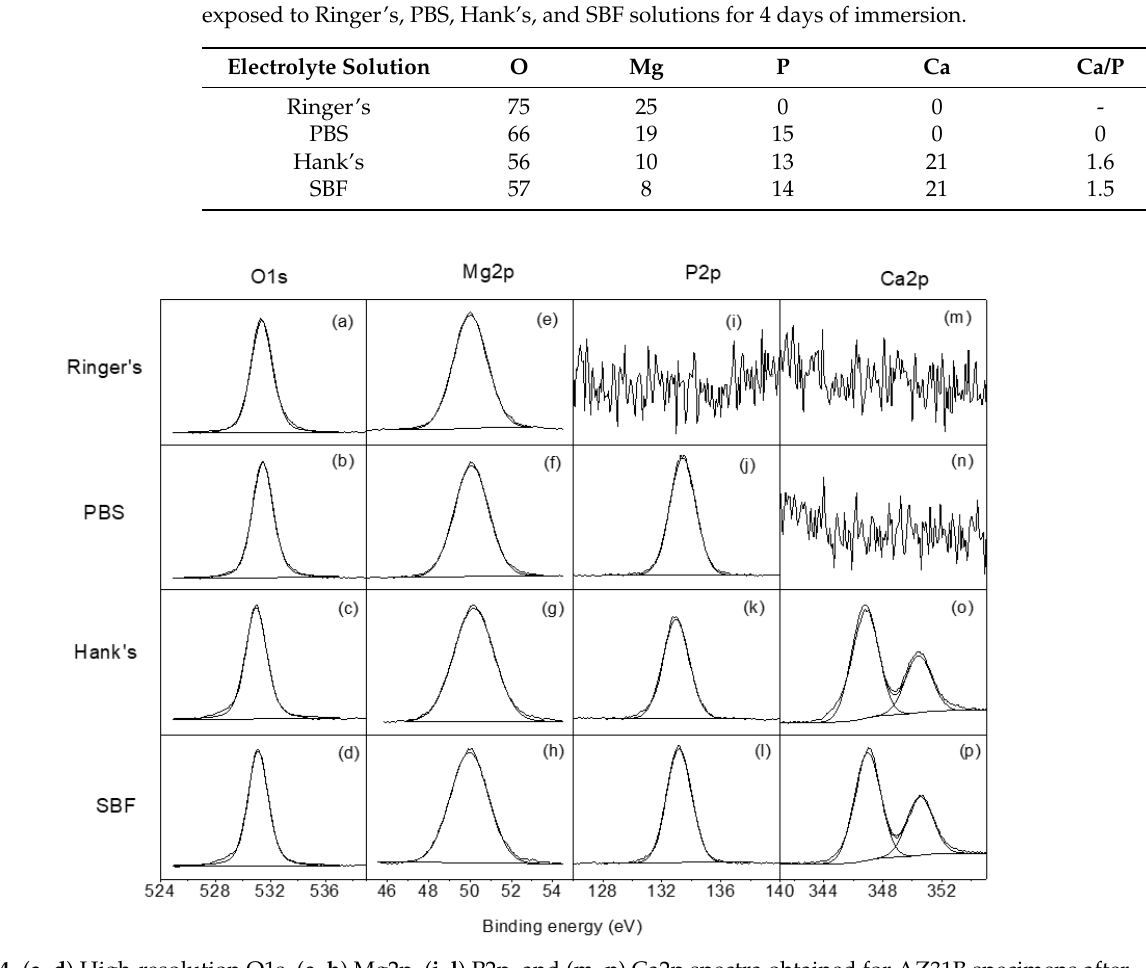
Figure 4. ( a – d ) High-resolution O1s, ( e – h ) Mg2p, ( i – l ) P2p, and ( m – p ) Ca2p spectra obtained for AZ31B specimens after immersion in Ringer’s, PBS, Hank’s , and SBF solutions for 4 days.